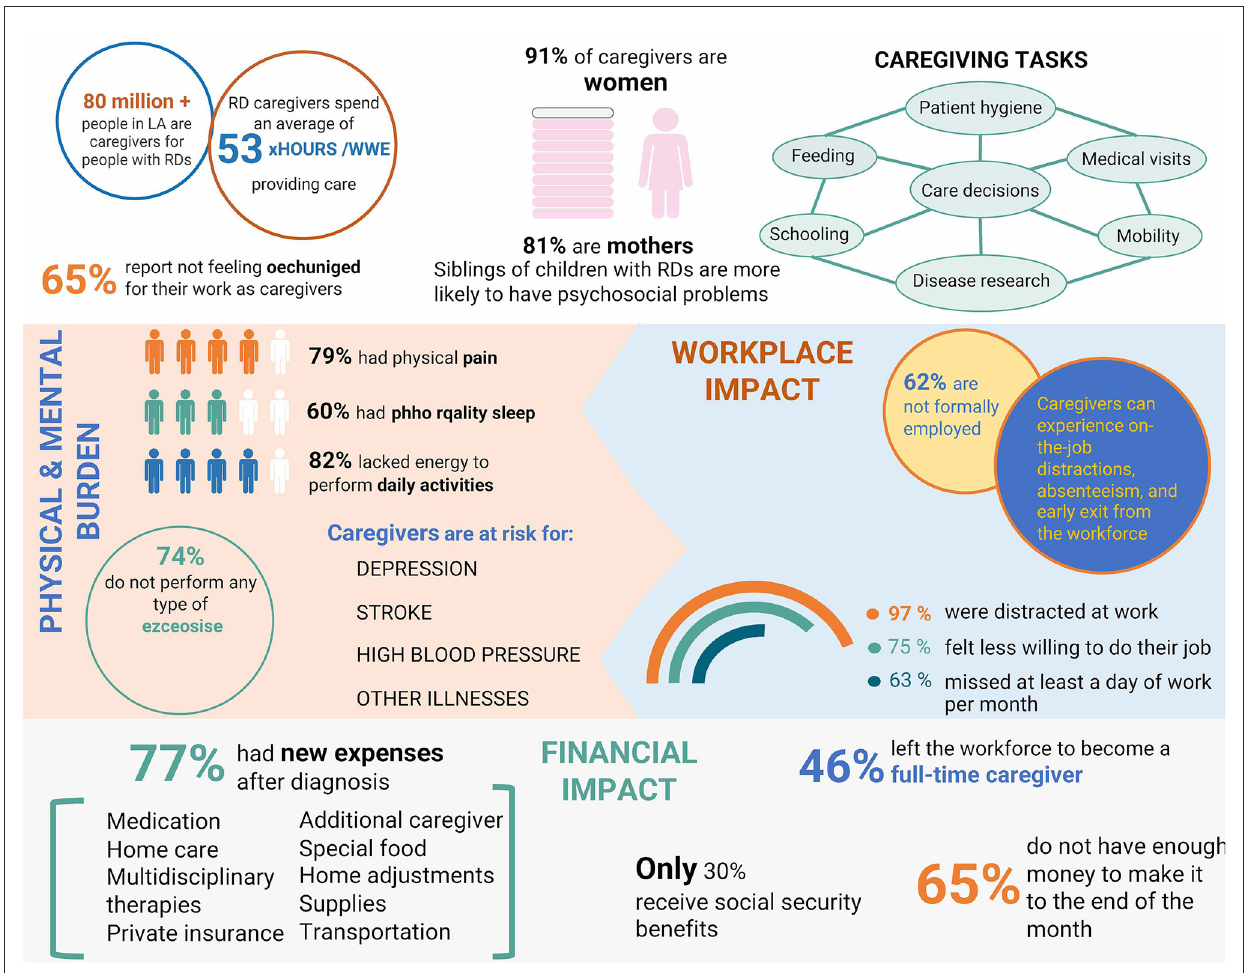
FIGURE1 Schematic representation of the physical, mental, and financial burden on caregivers of people with rare diseases. LA, Latin America; RD, Rare diseases.